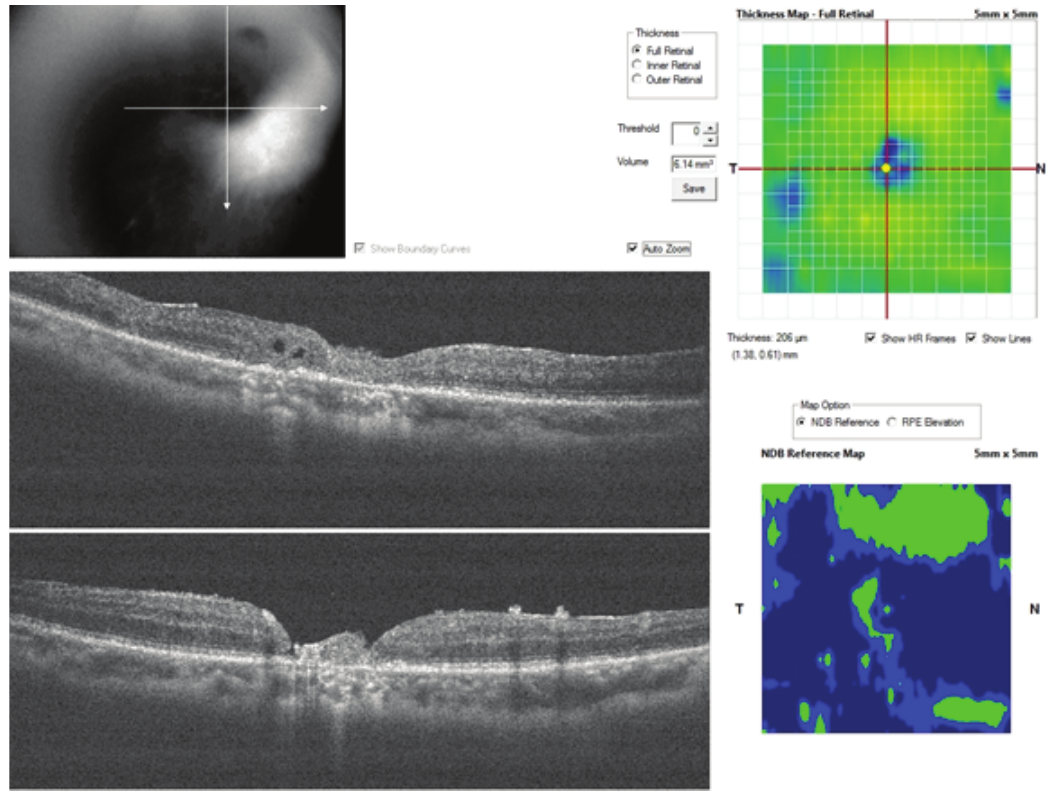
Figure 8. Patient 3; postoperative OCT cross-line horizontal and vertical scans showing retraction of the retinal graft and no preservation of the intraretinal